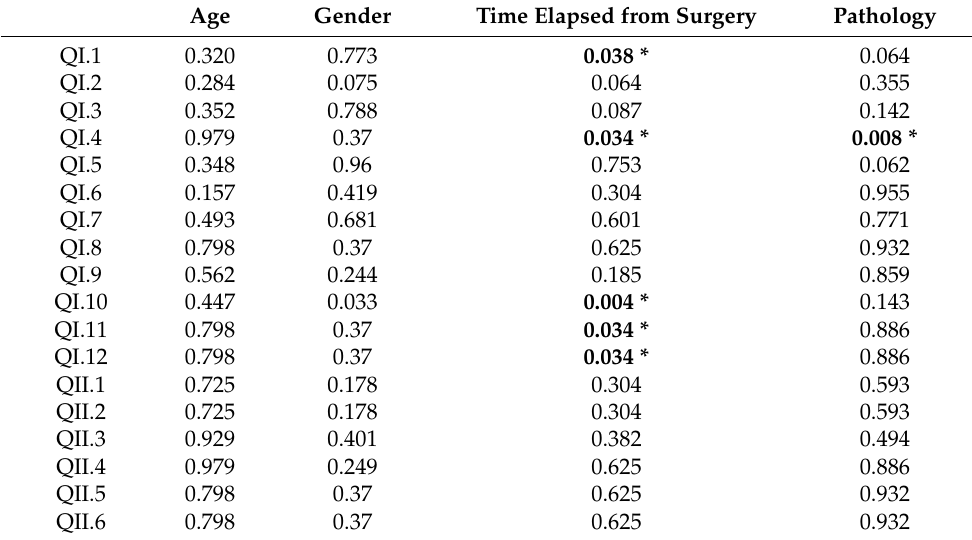
Table 3. Pearson chi-square test with p values at T0. Age Gender Time Elapsed from Surgery